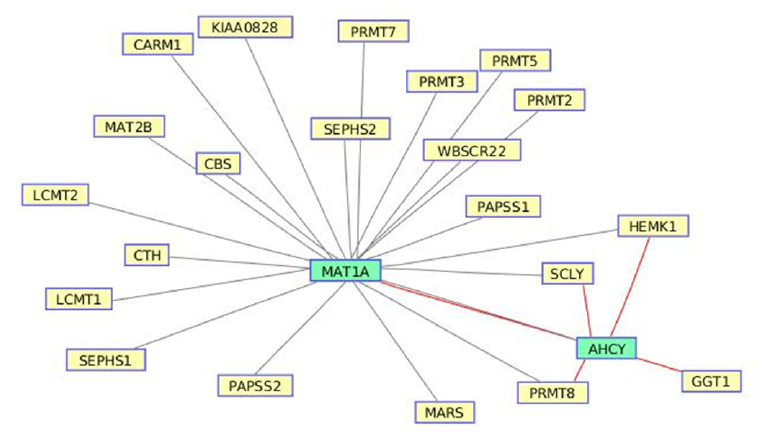
Figure 3. Diagram of gene–gene interactions in the SelAM pathway induced by valproic acid. The red and black lines represent inhibition and activation, respectively. red and black lines represent inhibition and activation, respectively.